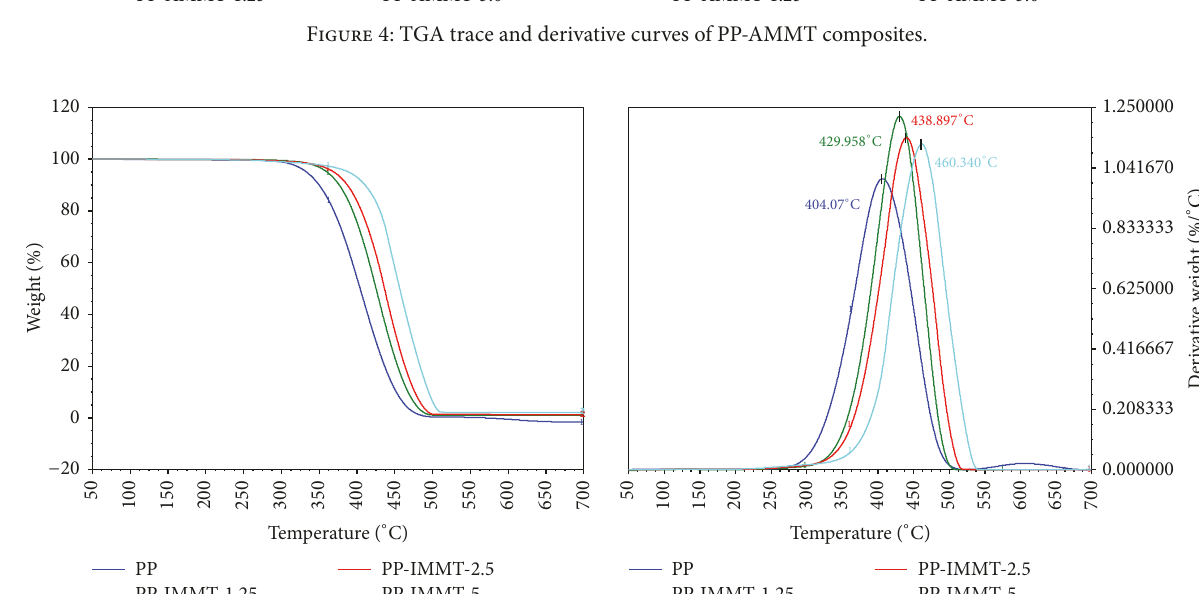
PP PP-AMMT-1.25